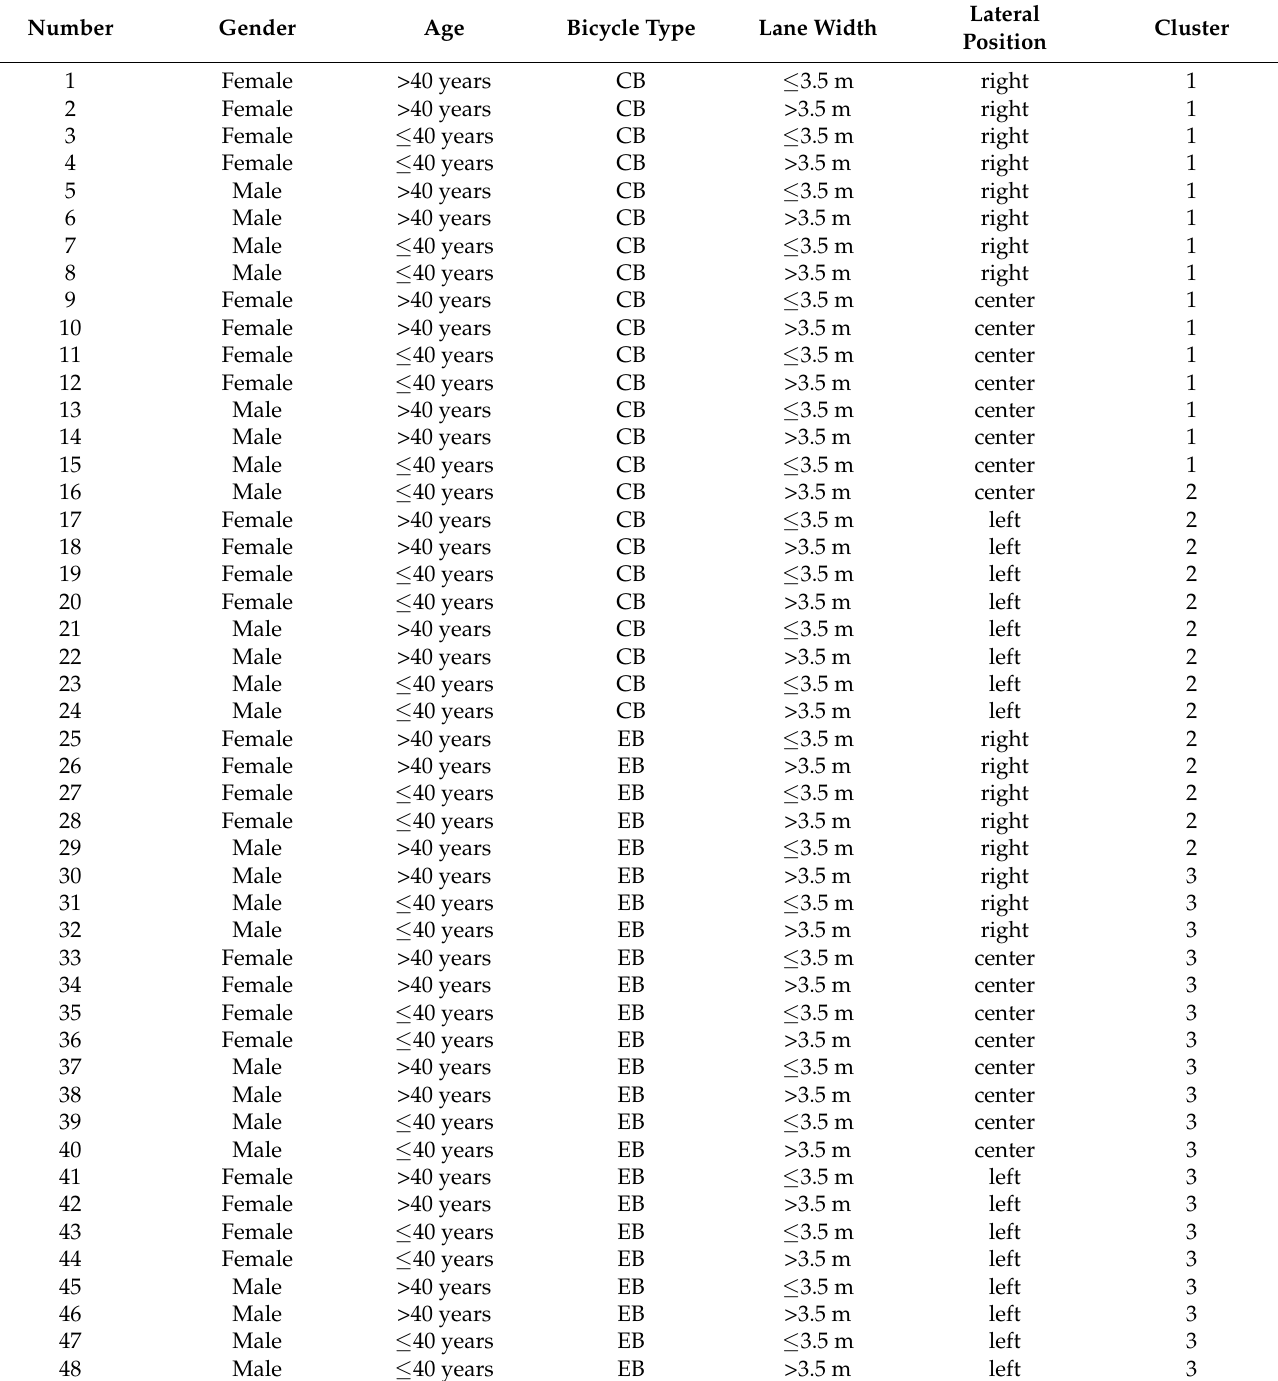
Table A2. Sorting and Clustering Results for 48